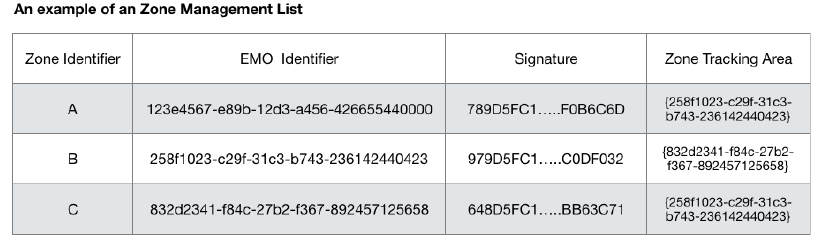
Figure 6. An example of ZML generated by the